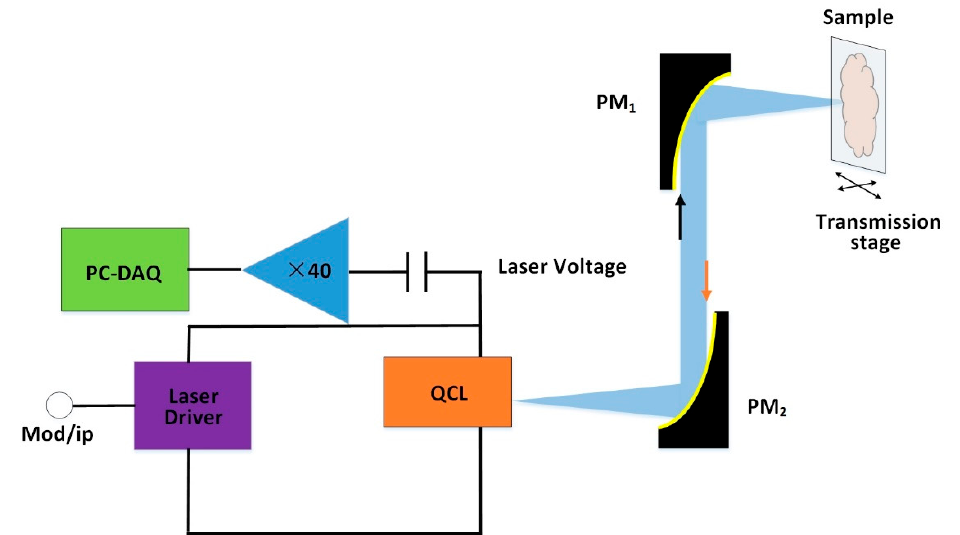
Figure 7. Schematic diagram of the CW-THz self-mixing coherent imaging. Another single-point phase contrast imaging method is based on THz heterodyne detection. By mixing the radiofrequency signals with the low-noise local oscillator signals, the measured signal can be converted into an intermediate frequency signal of microwave radio frequency and can then be detected by a heterodyne detector. In 2011, Lisauskas et al. studied a CW THz single-point scanning phase contrast imaging system based on the frequency of 0.6 THz and a CMOS THz raster scanning heterodyne mixer detector instead of a Schottky diode. The THz beam diameter was 30 mm [24]. The system scanned 1000 points on a freshly cut leaf, each point required 30 ms, and the scanning speed was 30